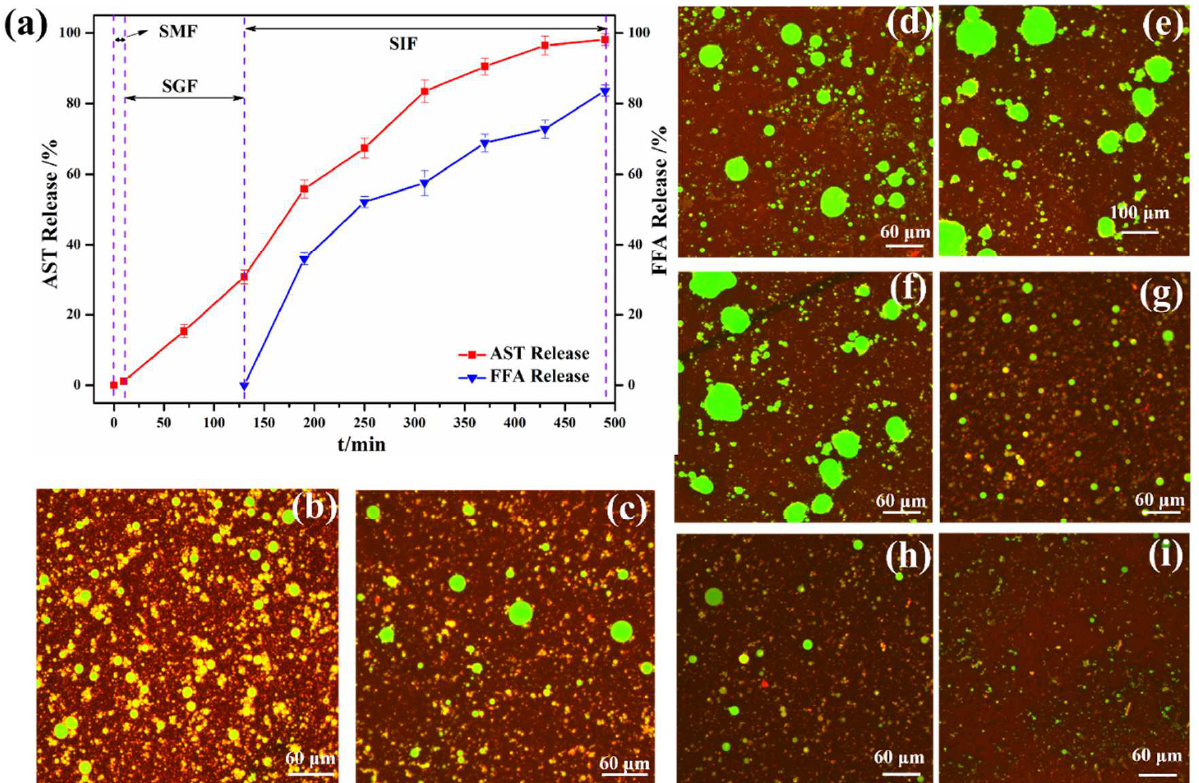
Figure 8. Release behaviors of AST-enriched emulsions in simulated digestion fluids ( a ). Fluorescence micrographs of AST-enriched emulsions after in vitro digestion (( b ): SMF at 10 min; ( c ): SGF at 2 h; and ( d – i ): SIF at 1, 2, 3, 4, 5, and 6 h). Scale bars are 60 μm.